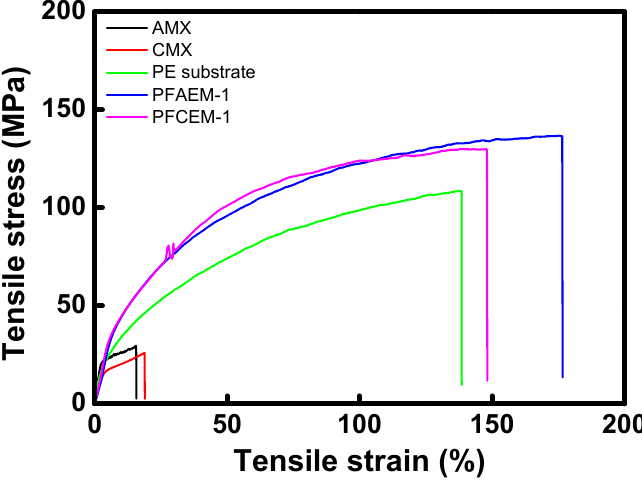
Figure 7. Tensile stress–stain curves of commercial IEMs, porous substrate, and PFIEMs.